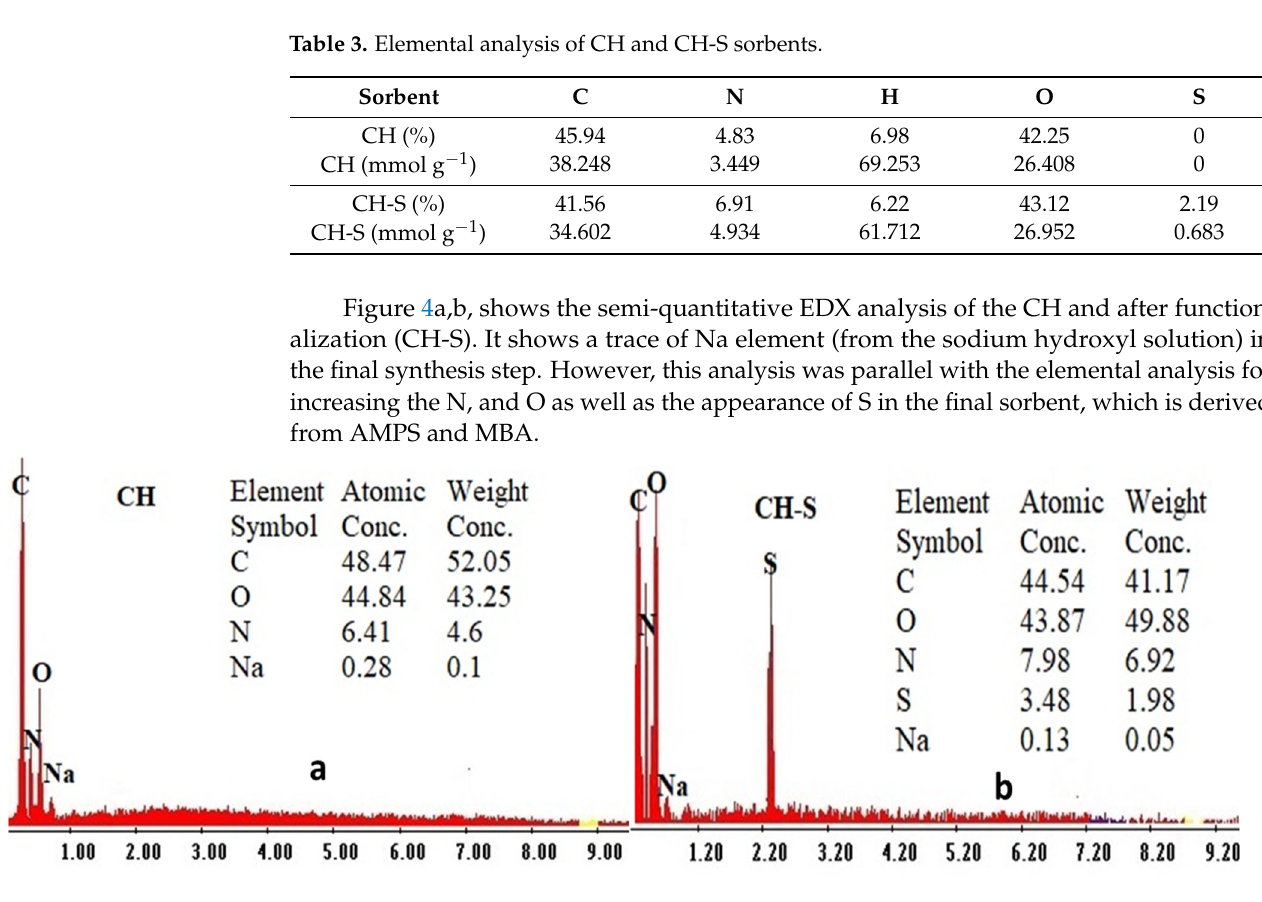
Figure 4. EDX analysis of CH ( a ) and CH ‐ S ( b